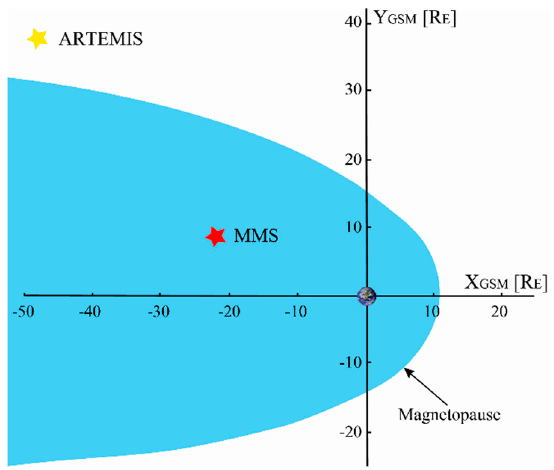
Figure 4. The locations of MMS (denoted by red pentagram) and ARTEMIS (denoted by yellow pentagram) in the GSM coordinates on 4 August 2017.The figure is in the same format as Figure 1. Atmosphere 2020 , 11 , x FOR PEER REVIEW